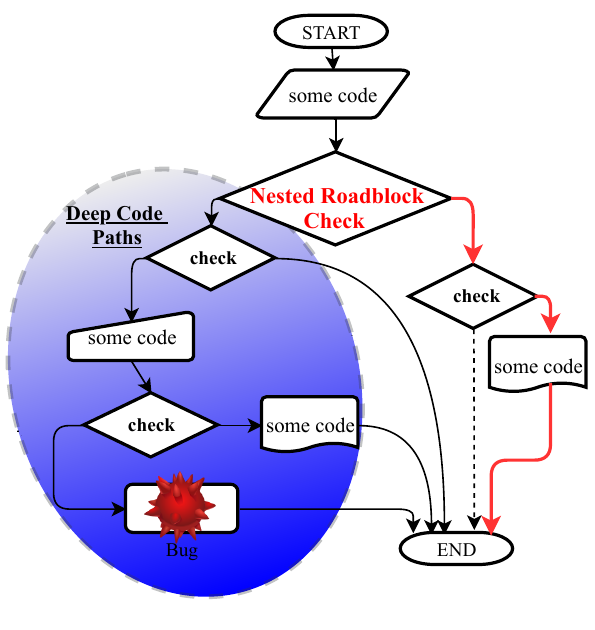
Figure 1. Challenge for fuzz testing